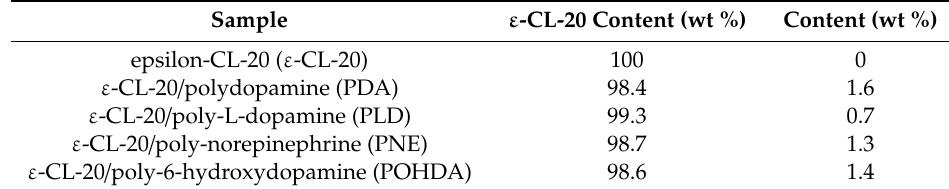
Table 1. Composition of core ‐ shell microcapsules.